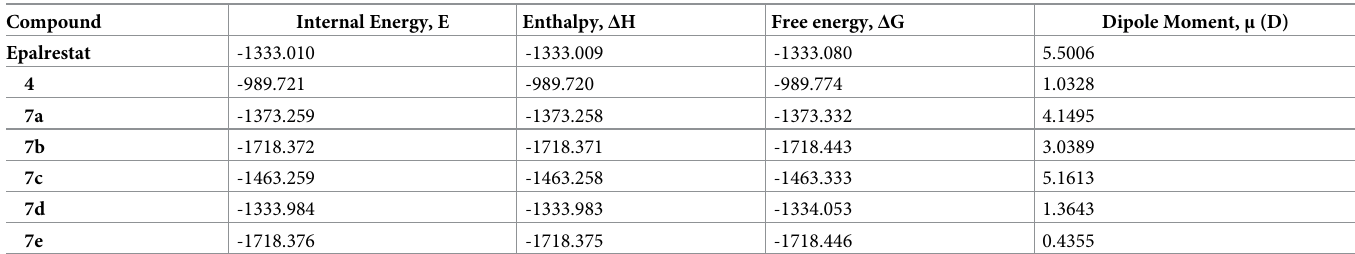
Table 1. Theoretical thermodynamic results of Epalrestat, compound 4 and 7a-e. Compound